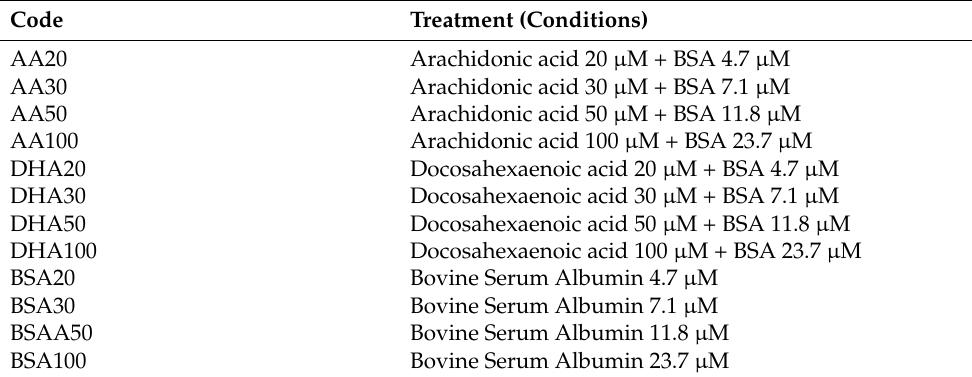
Table 1. The experimental code used in xCELLigence RTCA system. Code Treatment